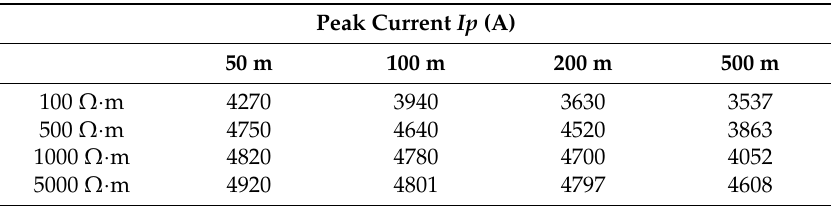
Table 3. Peak currents in amperes due to lightning stroke in the MV cables.